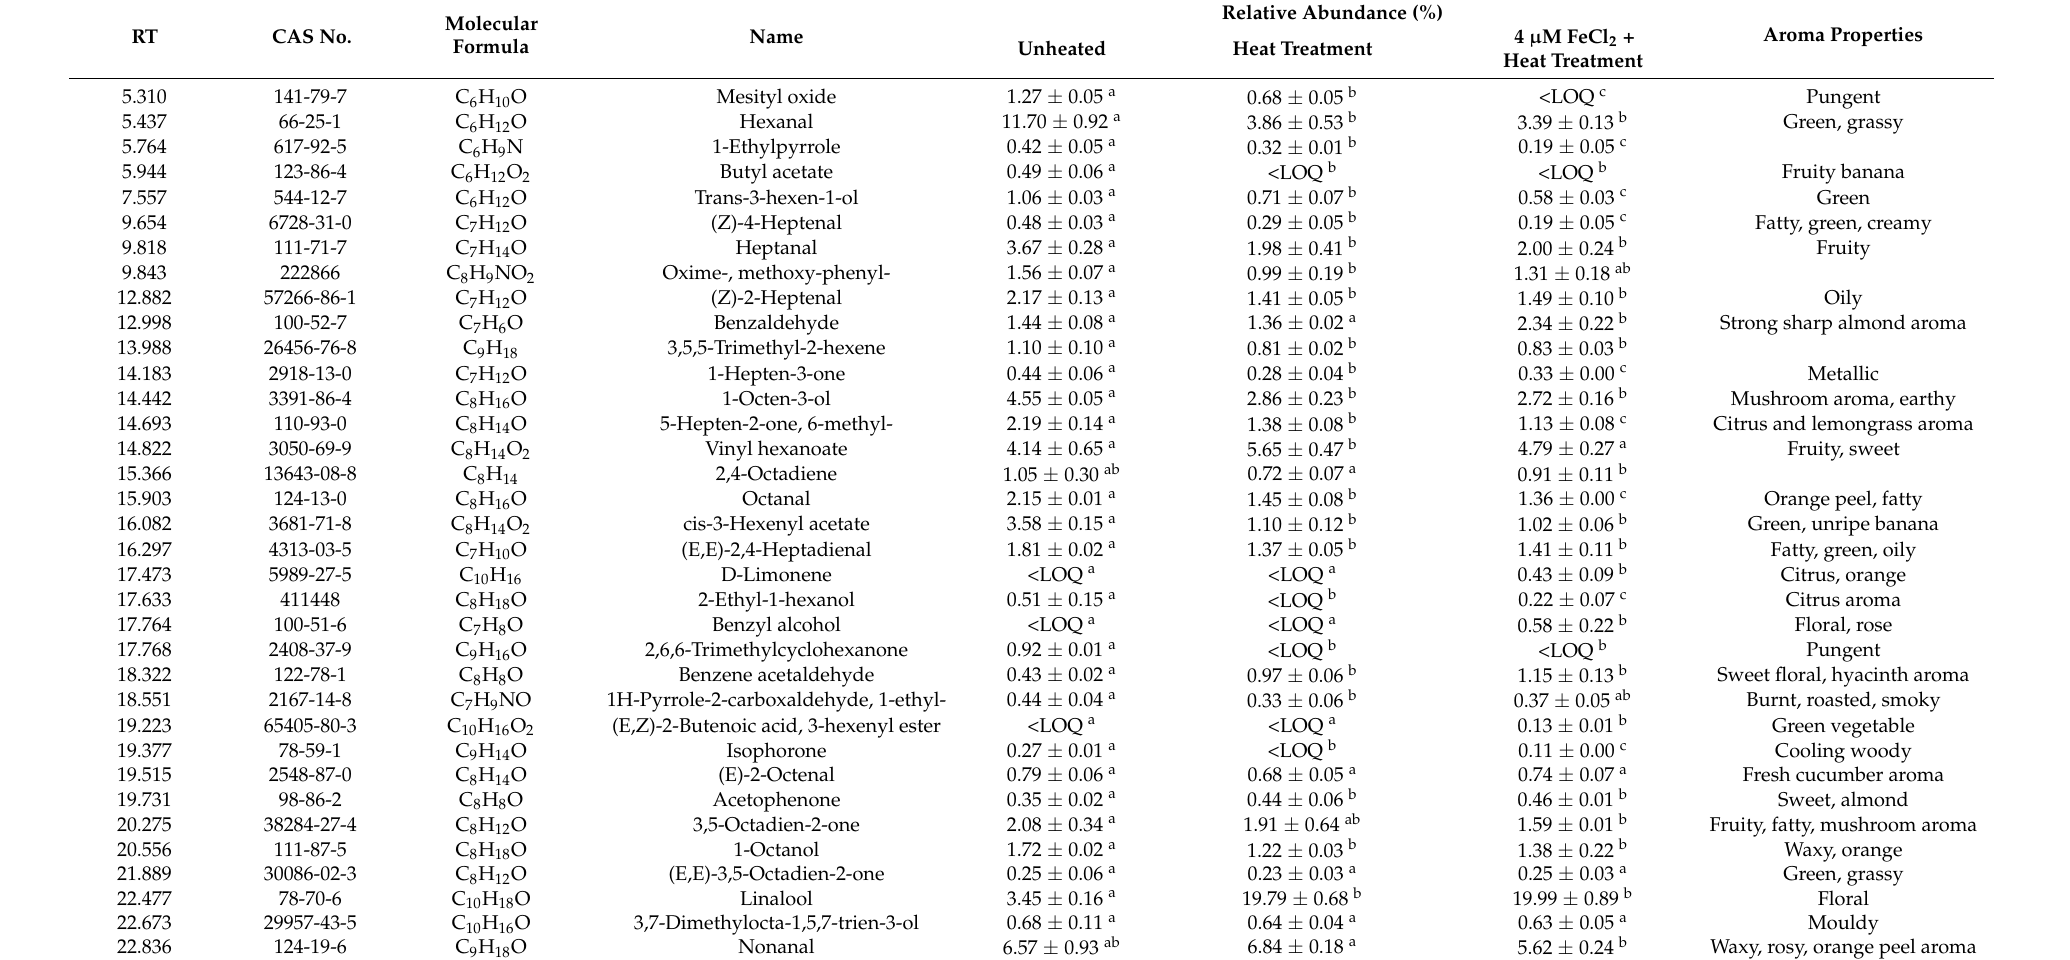
Table 5. Effect of Fe 2+ on the volatile profile of green tea infusion with heat